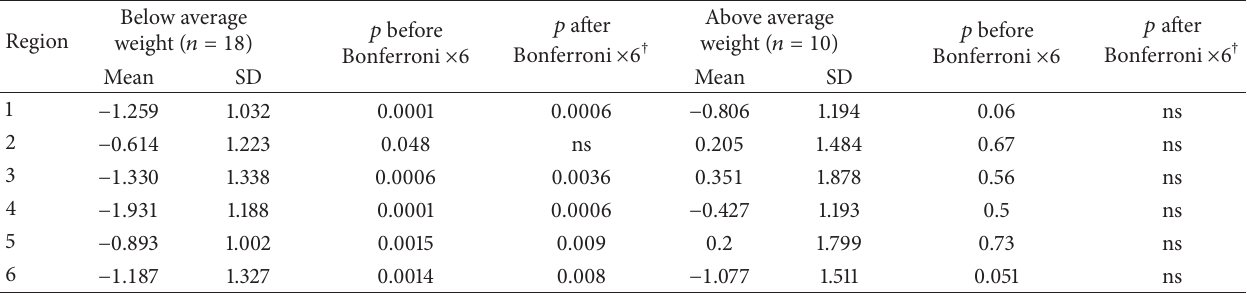
Table 3: BMD 𝑧 wc scores for coeliac patients above and below average